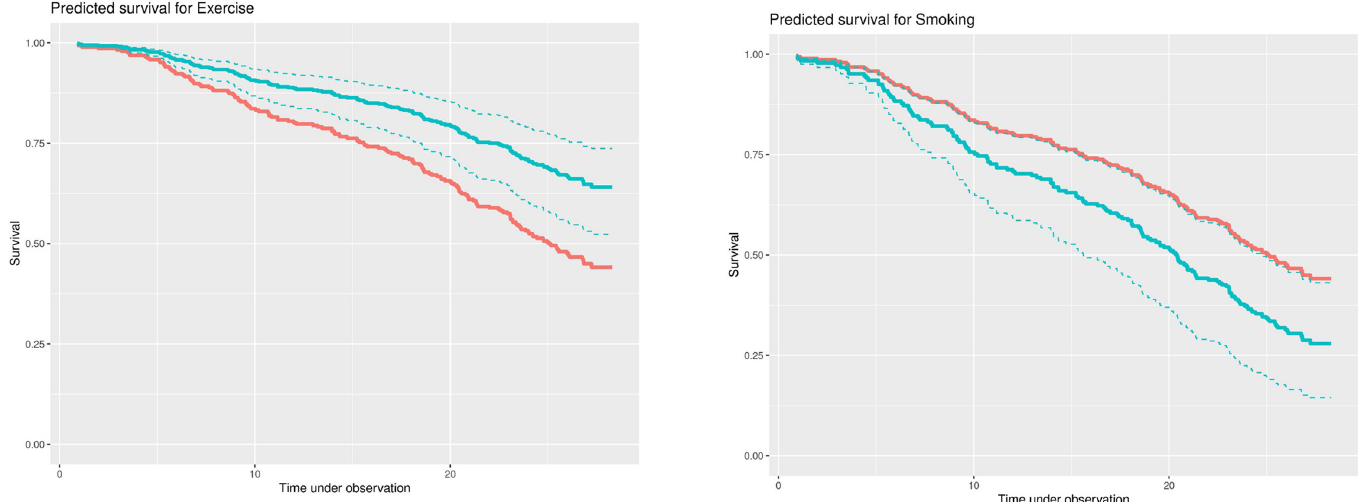
Fig 3. Predicting survival for exercise and non-smoking in women with CAD. HRs do not allow quantifying effects on survival directly, therefore, predicted survival curves are displayed for a selection of covariates from the final model. For all plots, orange codes the baseline survival curve, cyan codes survival for relevant values of the covariate considered. a) Exercise. Moderate Exercise seems to be beneficial, showing an increase in survival of 20% appr. b) Smoking . Smokers might have a reduced chance of survival during follow up of up to 17%